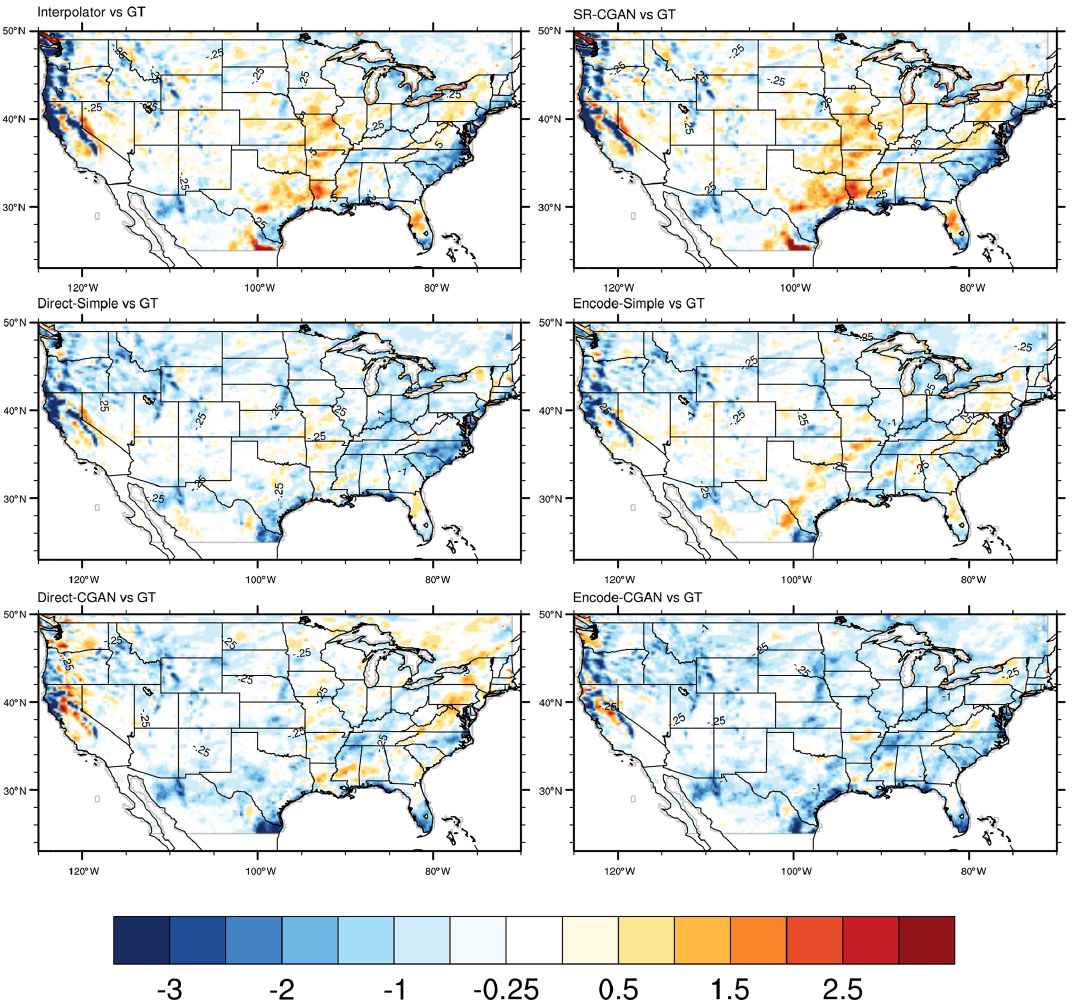
Figure 10. The differences (predictive models vs. Ground Truth) in the top 5% (averaged across the 95th percentile to maximum) of the precipitation amount (mm/3h) during the testing period